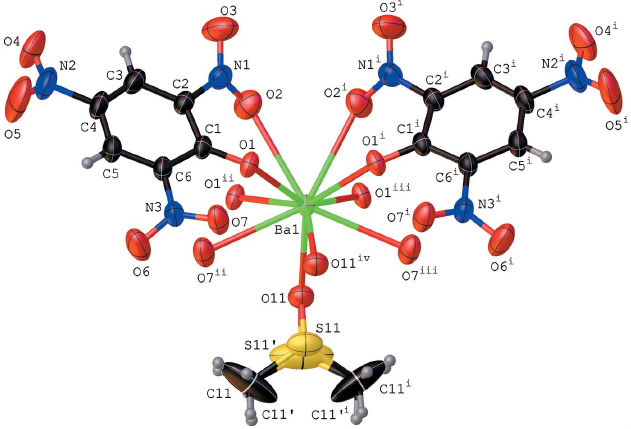
Figure 1 The coordination environment of the Ba II atom in the crystal structure of [Ba(C 6 H 2 N 3 O 7 ) 2 (C 2 H 6 OS)]. Displacement ellipsoids are drawn at the 50% probability level for non-hydrogen atoms. [Symmetry codes: (i) x , (cid:5) y + 1 , z ; (ii) x (cid:5) 1, y , z ; (iii) x , (cid:5) y + 1 2